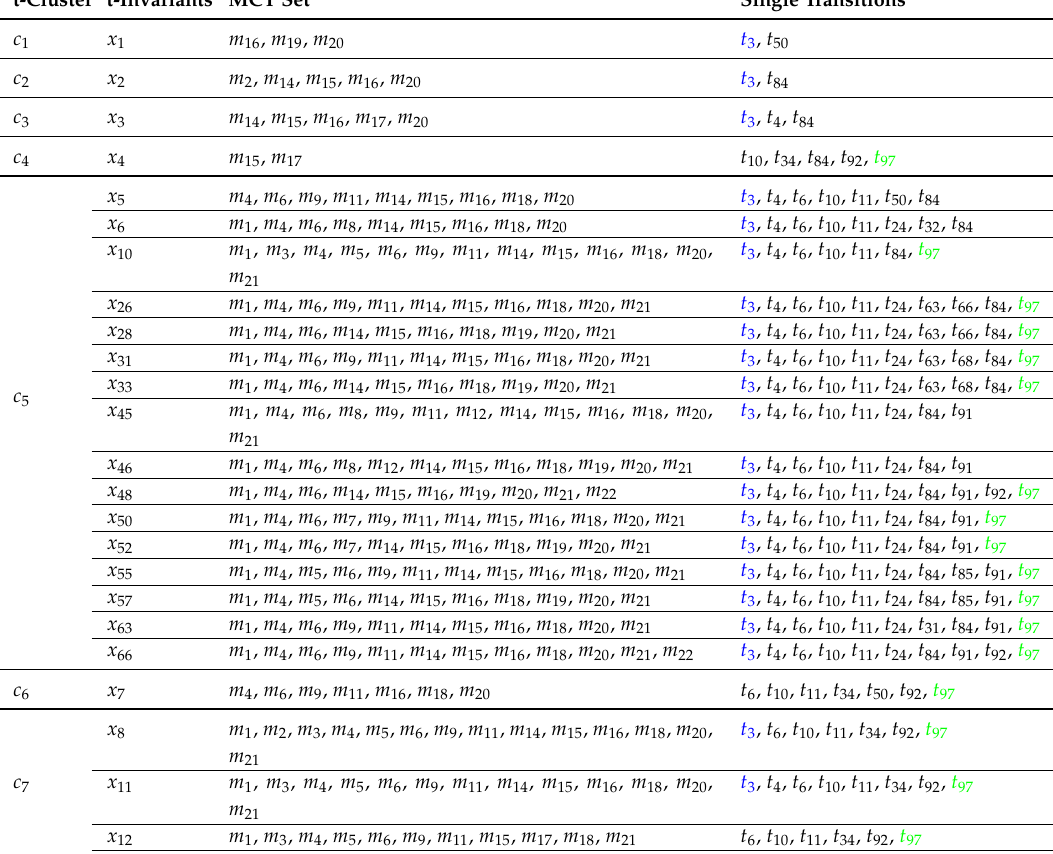
Table A3. List of t-clusters. The column “t-clusters” includes the names of t-clusters, the column “t-invariants” includes the names of t-invariants which are included in the particular t-cluster, the column “MCT set” includes the names of MCT set which are related to particular t-invariant and in the column “single transitions” two transitions have been distinguished: t 3 —activation of caspase 8 (marked with blue color) and t 97 —IL-18 synthesis mediated by caspase 1-independent pathway (marked with green